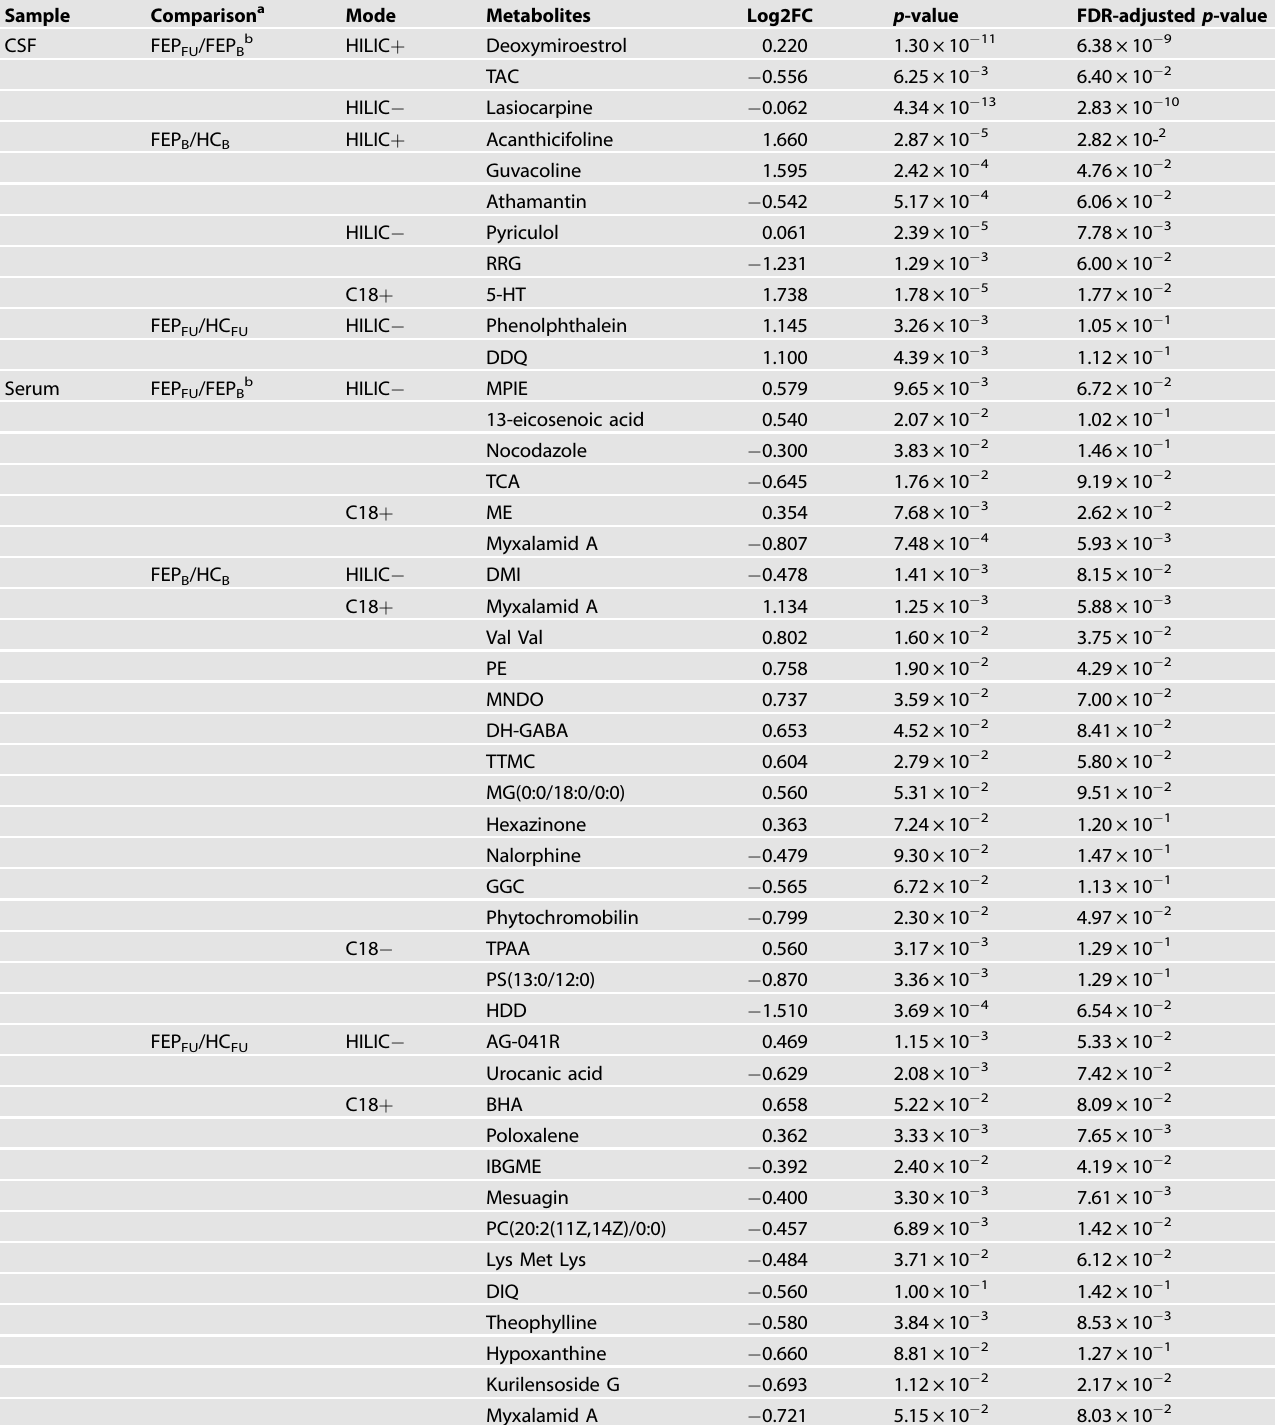
Table 3. List of identi fi ed follow-up-associated CSF and serum metabolites.